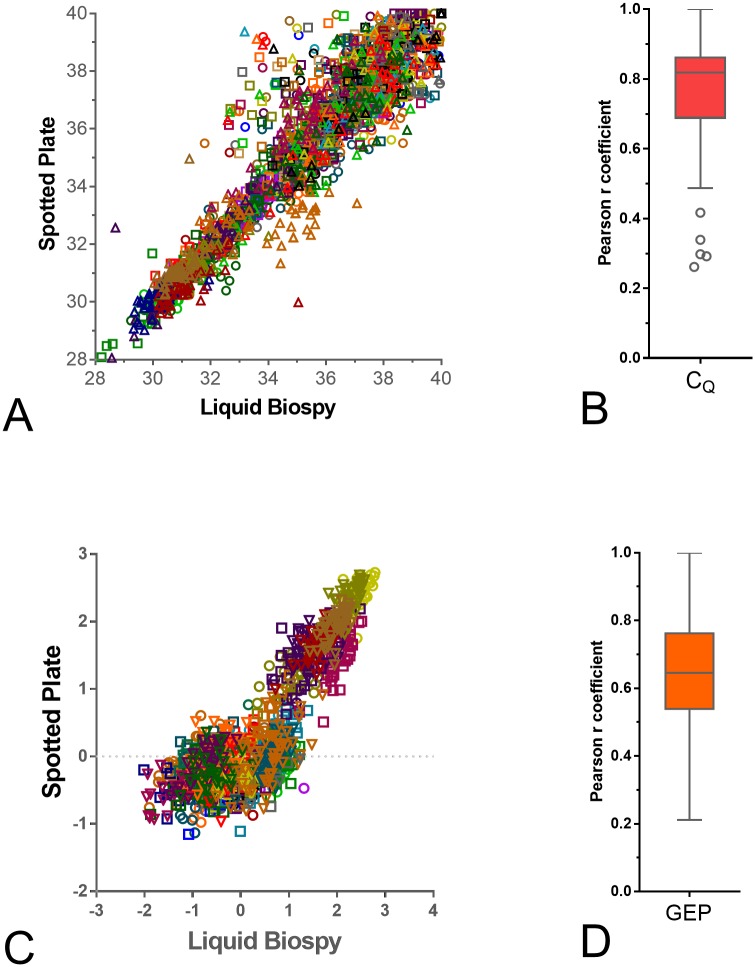
Concordance between CQ and normalized gene expression levels in Sample Set I (n = 44).2A/B. CQ levels. Scatter plot based on CQ for each of the target genes (genes are individually colored) on spotted plates versus the standard approach (2A). The individual Pearson values ranged from 0.29–0.98. The Tukey box and whisker’s plot of the individual r-values (2B) identify the mean was 0.76 and median 0.82. 2C/D. Gene expression. Scatter plot based on normalized gene expression for each of the target genes (individually colored) on spotted plates versus the standard liquid approach (2C). The individual Pearson values ranged from 0.21–0.98. The Tukey box and whisker’s plot of the individual r-values identify the mean was 0.65 and median 0.65 (2D).